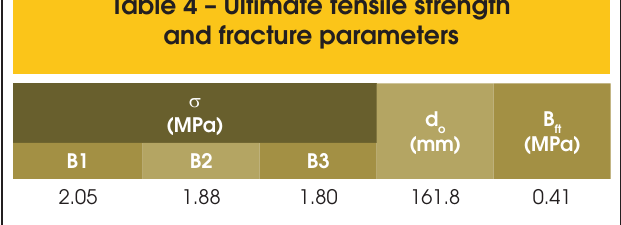
Figure 12 – Bazant's size effect